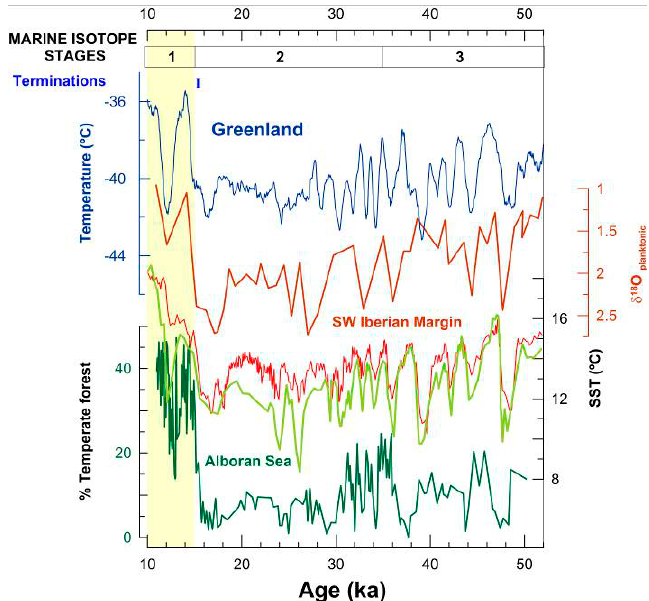
Figure 11. Climate records from the Iberian margin compared with Greenland temperature for the last 52,000 years. Variations of temperate forest recorded in the Alboran Sea (dark green) [114] correlate well with SST from both the Alboran Sea (light green) and the Southwest Iberian margin (red) [56], with the planktonic δ 18 O from the SW Iberian margin (dark red) [79] and with temperature over Greenland (blue) [37]. Marine isotope stages and terminations (in roman numerals) are represented on top. The yellow band highlights the interglacial stage.